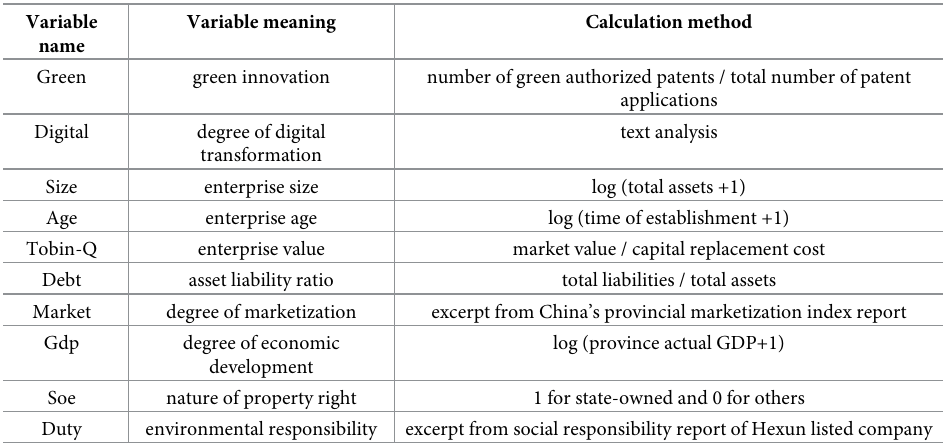
Table 1. Main variables.